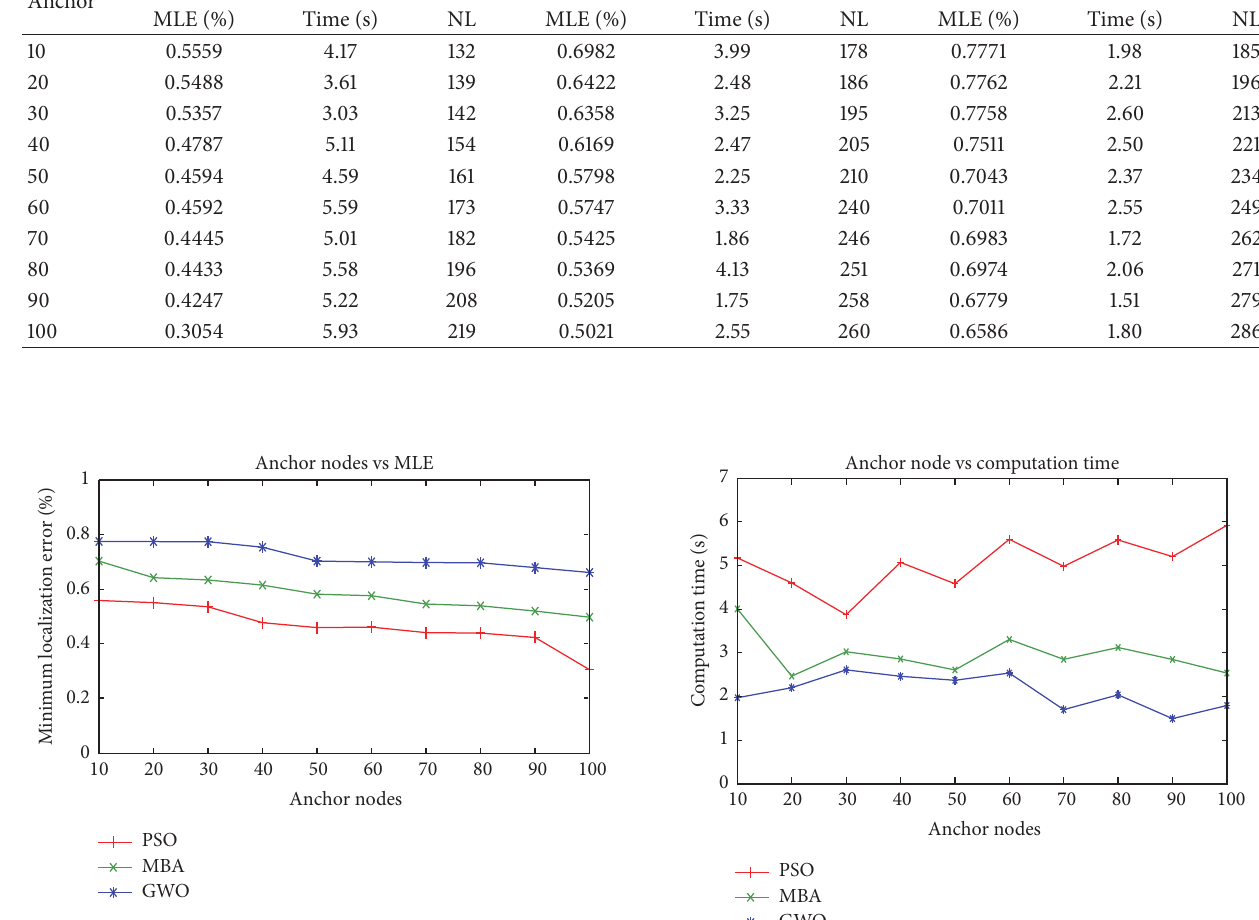
Table 2: Comparative analysis of mean localization error (MLE), computation time, and number of localized node (NL). Anchor